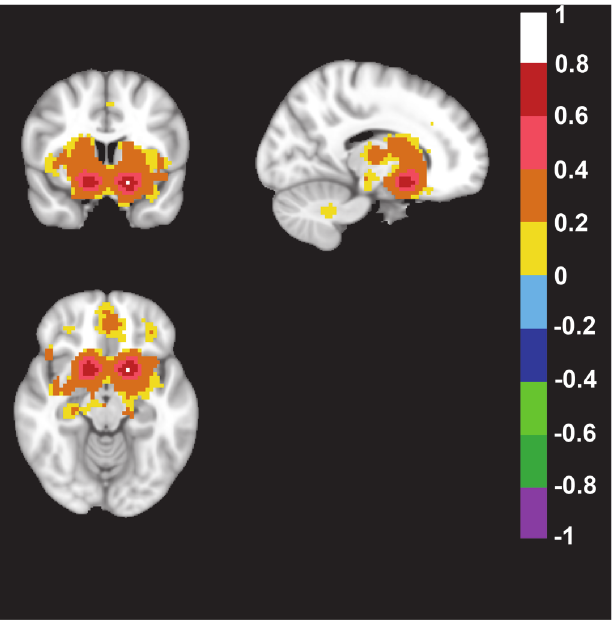
Fig 7. Human Ventral Basal Ganglia Network. A bilateral seed placed in Talairach coordinates in mm: +/-14; 5; -8 revealed the ventral basal ganglia network. Top left image displays an axial, top right a sagital and bottom image a coronal view of the human brain. Note the possitive FC-values of the bilateral nucleus accumbens in the axial view, the unilateral sagittal view of nucleus accumbens and the possitive FC-values in the caudate as well as putamen, and the coronal bilateral view of nucleus accumbens as well as lower possitive FC-values indicating a part of the ventromedial prefrontal cortical region. FC-values are displayed with a pseudo-colored scale bar; with increments of 0.2 each designated a color (see the color-bar in the image).